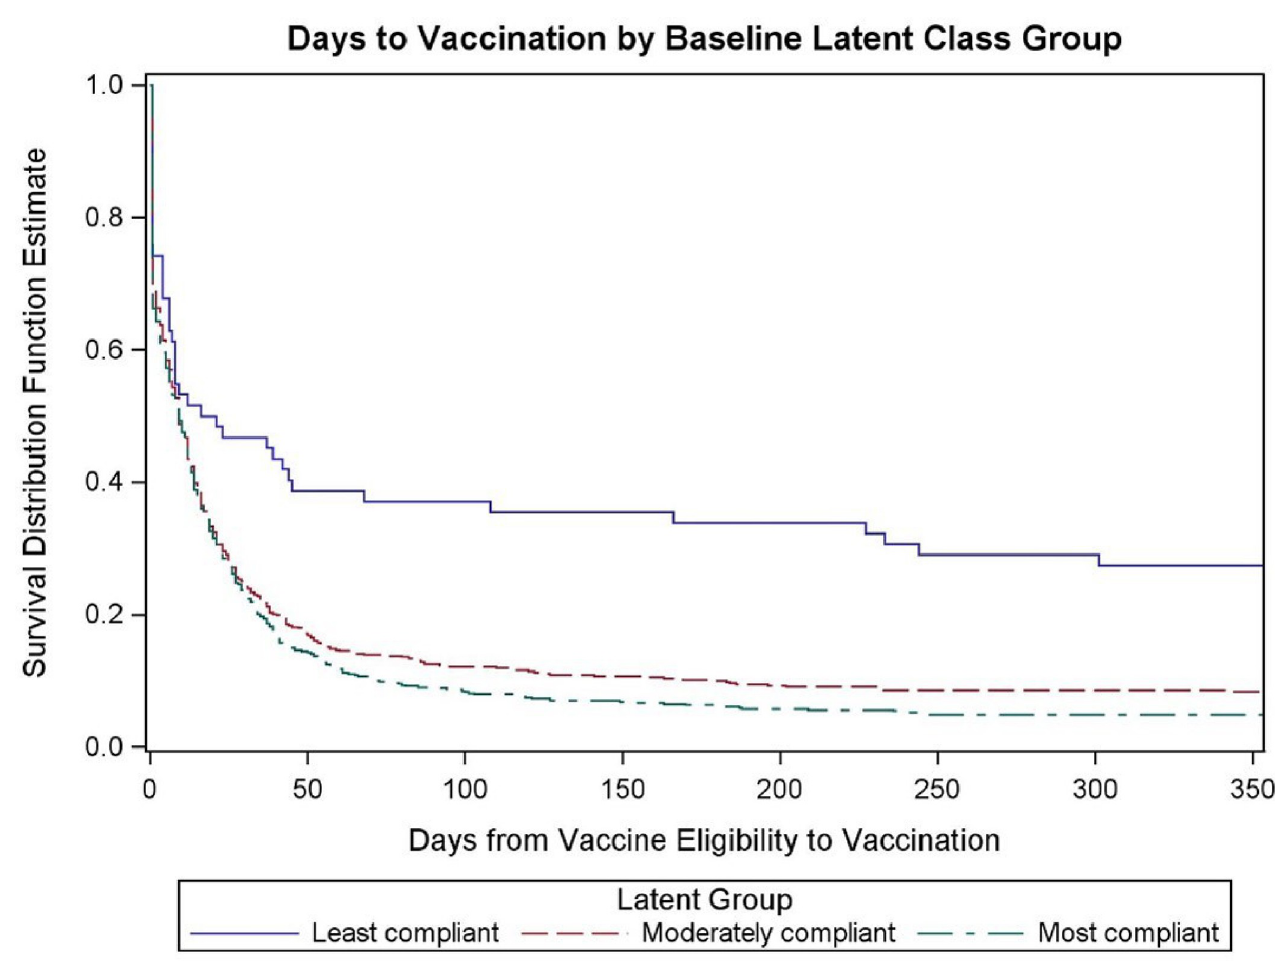
Fig 2. Days to vaccination by compliance